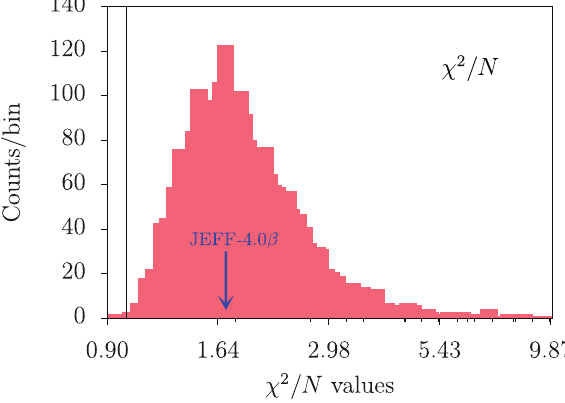
Fig. 2. Distribution of the χ 2 per degree of freedom consider- ing sampled (random) H in H 2 O thermal scattering data. The vertical black line indicates the position of χ 2 /N = 1